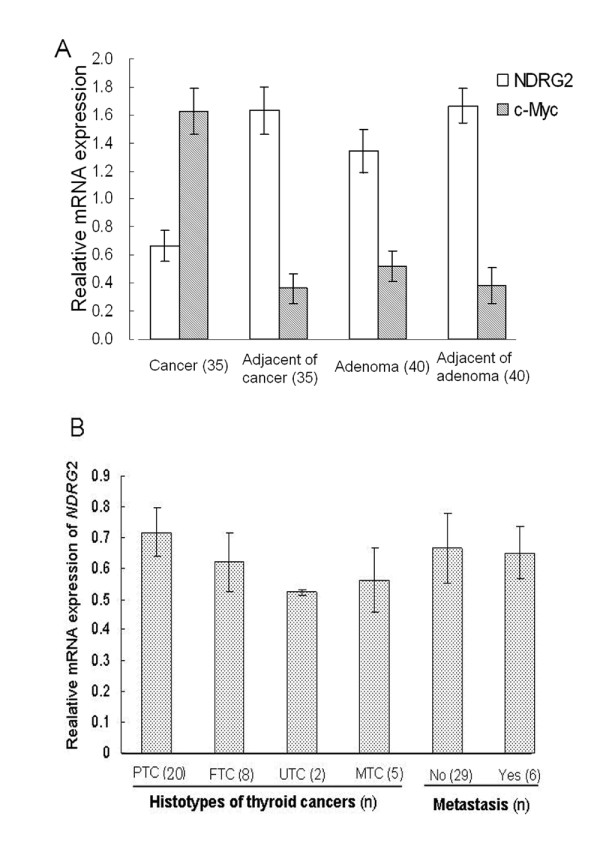
Reduced NDRG2 and increased c-MYC mRNA level in thyroid cancers. (A) Real-time PCR was used to detect differences in NDRG2 and c-MYC RNA levels in thyroid tissues. The mean values of NDRG2 and c-MYC mRNA levels were calculated after normalization to the expression of GAPDH. The P values comparing the expression of NDRG2 and c-MYC between the thyroid cancer and the adjacent normal tissues were below 0.05. (B) Analysis of NDRG2 expression using the different histotypes and distant metastasis of thyroid cancer. There are four histotypes of thyroid cancers, including papillary carcinomas (PTC), follicular carcinomas (FTC), medullary carcinomas (MTC) and undifferentiated carcinomas (UTC). N in the bracket indicates the numbers of each histotype. There were six patients with distal metastases and 29 with no metastasis. p > 0.05.